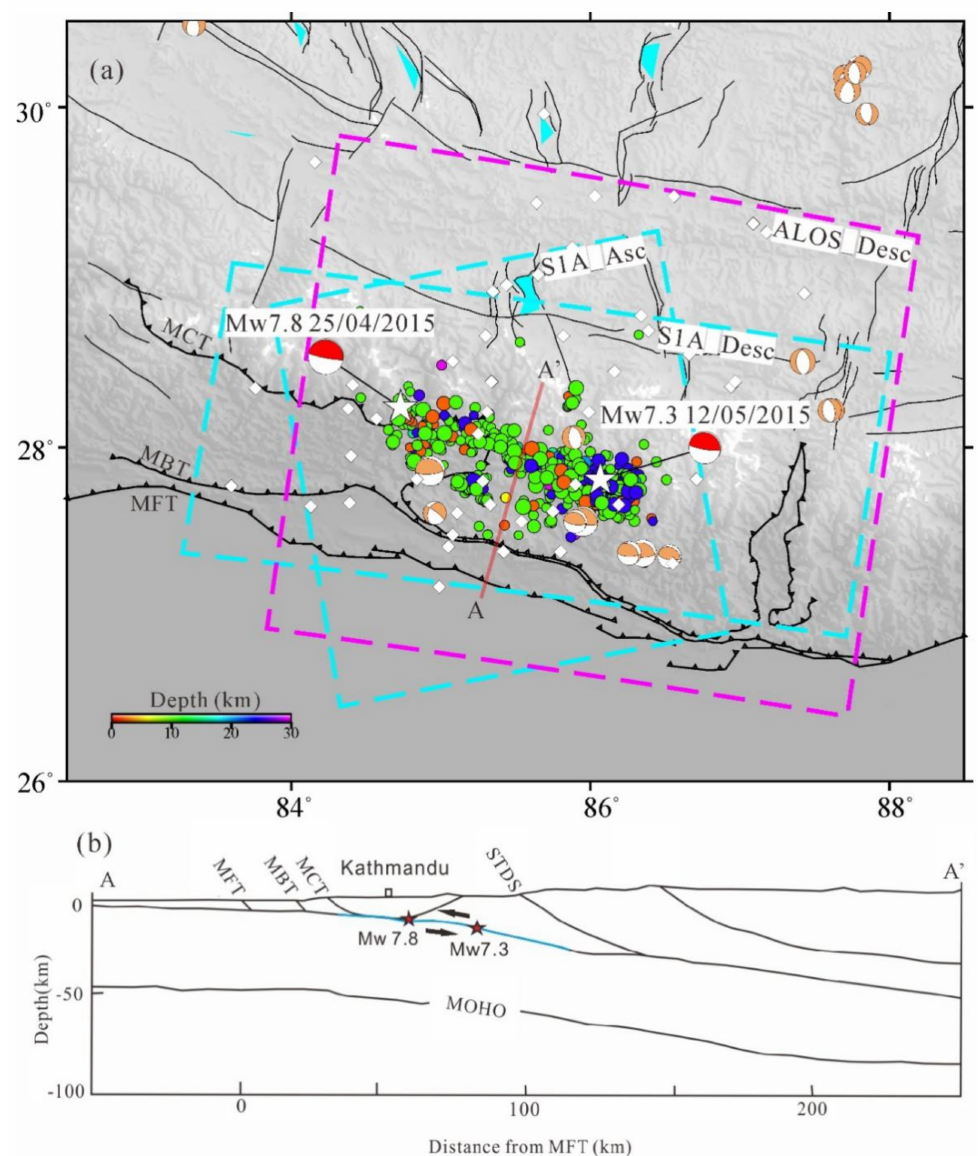
Figure 1. ( a ) Tectonic setting of the Nepal earthquake, the white star denotes the epicenter of the Mw 7.8 and Mw 7.3 earthquakes; the sky-blue dashed line represents the range of Sentinel-1A data; the pink dashed line represents the range of ALOS-2 data; the white diamond represents the GPS station; the orange beach balls indicate the distribution of Mw > 6.0 aftershocks; the black line denotes the fault distribution; the colored dots indicate the aftershock distribution (45 days after Mw 7.8 earthquake); the red transparent line represents the surface trace of the section in ( b ). ( b ) Longitudinal section of the fault; MHT (the main Himalaya thrust fault); MFT (the main front thrust fault); MBT (the main boundary thrust fault); MCT (the main center thrust